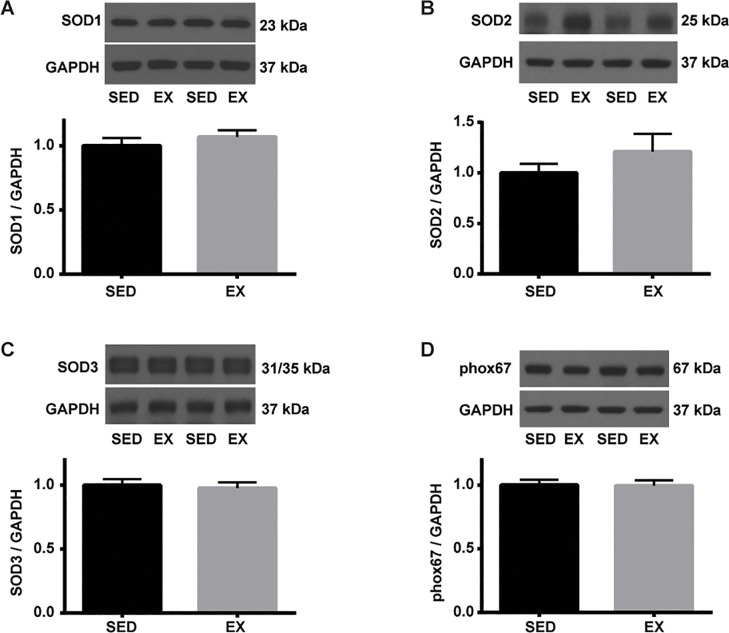
Levels of SOD and p67phox subunit of NADPH oxidase in the aorta of SED and EX mice.An equal amount of aortic homogenates was separated by SDS-PAGE. Representative blots are shown above each summary graph. Each protein level was normalized to GAPDH and expressed relative to SED mean (n = 7 per group). A. Representative blots of SOD1. B. Representative blots of SOD2. C. Representative blots of SOD3. D. Representative blots of p67phox, a subunit of NADPH oxidase.